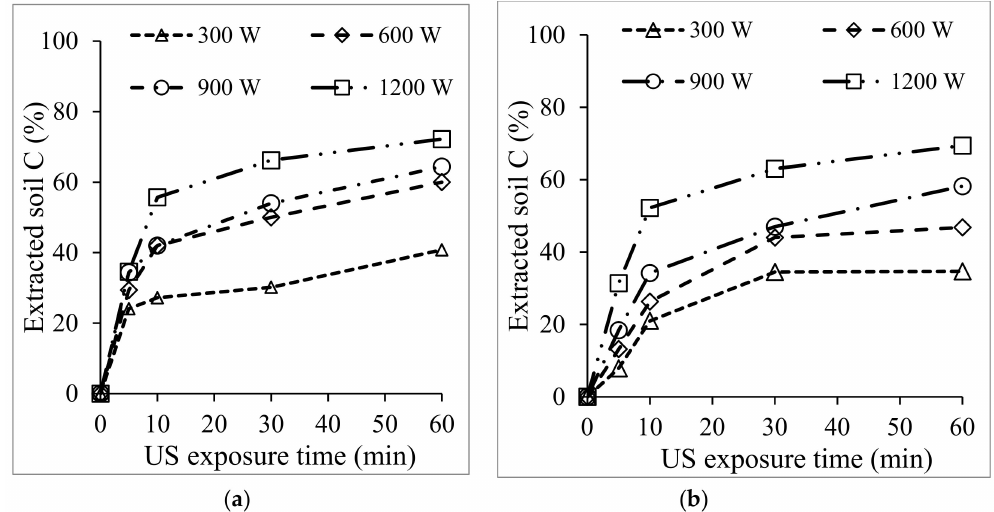
Figure 5. Calculated percentage of organic carbon extracted after 1200 W US exposure at di ff erent US power for ( a ) NH 3 and ( b ) NaOH